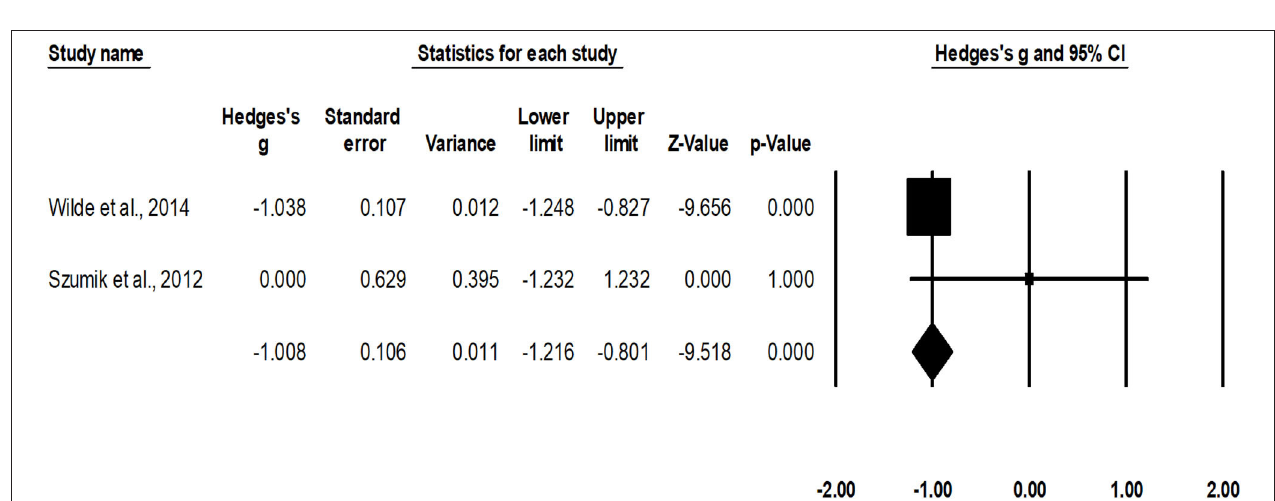
FIGURE 4 | Illustrates the forest plot for studies evaluating the effects of nephron sparing surgery on occurrence of relapse in children with unilateral Wilms tumor. Weighted effect size is presented as boxes; 95% CIs are presented as whiskers. They demonstrate relapse rate (%) in between cases operated with radical nephrectomy and nephron sparing surgery. A negative effect represents a reduced occurrence of relapse for nephron sparing surgery; a positive effect represents reduced occurrence of relapse for radical nephrectomy.